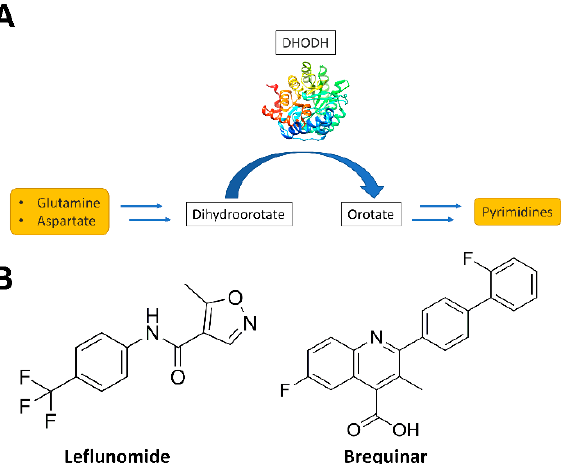
Figure 1. Scheme of the role of dihydroorotate dehydrogenase (DHODH) in de novo pyrimidine biosynthesis ( A ) and structures of the DHODH inhibitors leflunomide and brequinar ( B ). Leflunomide, together with its metabolite teriflunomide, has been approved for